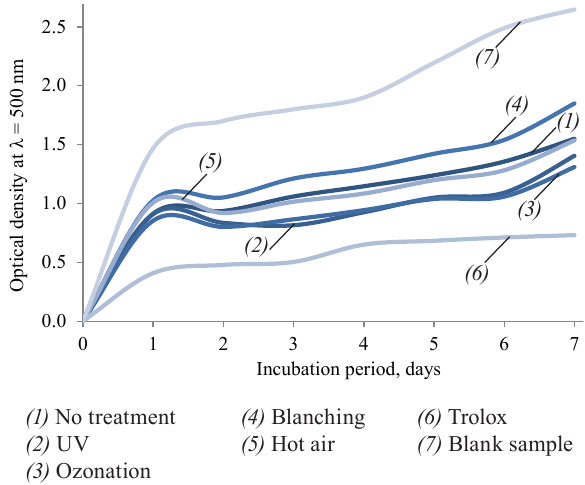
Figure 2 Effect of various methods of preliminary disinfection on the LPO inhibition of the freeze-dried